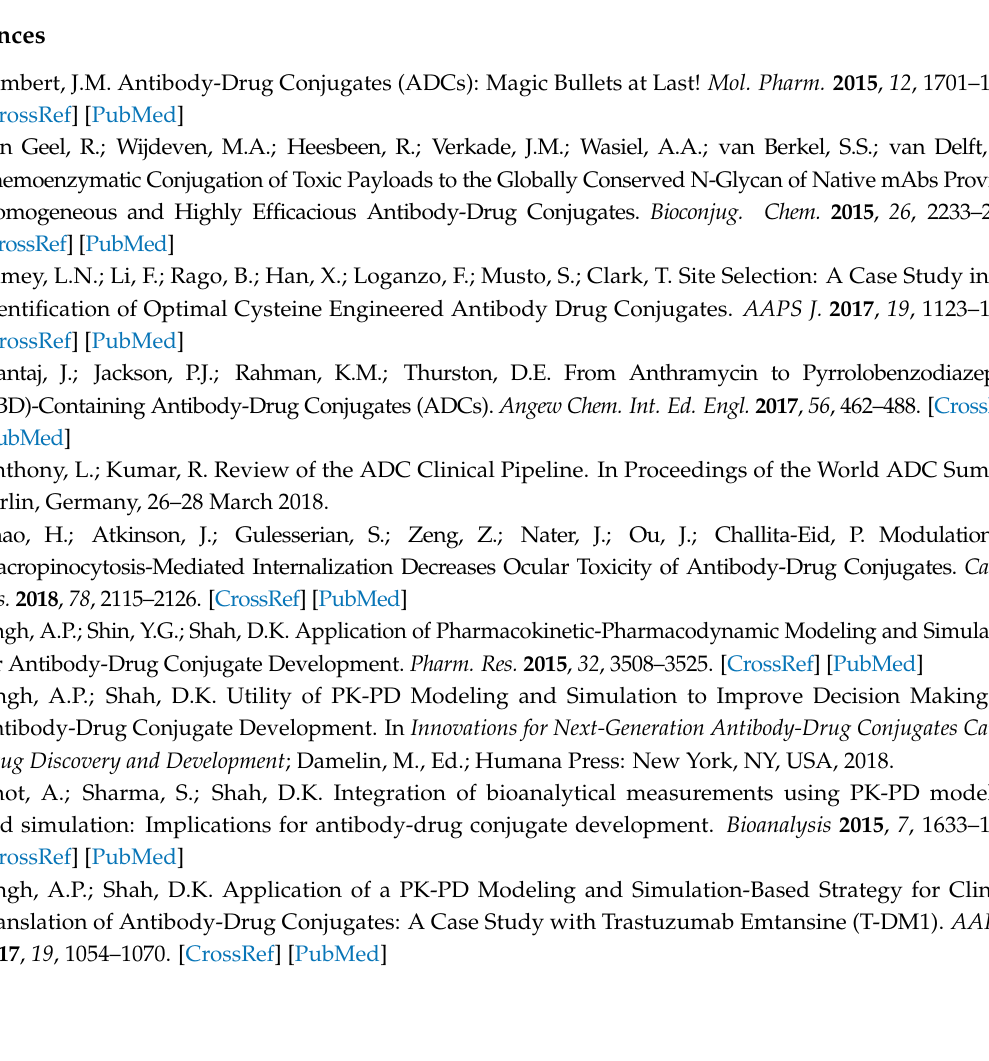
Figure S1. Schematic of the plasma PK model for ADC. Figure S2. Schematics of the tumor distribution model for